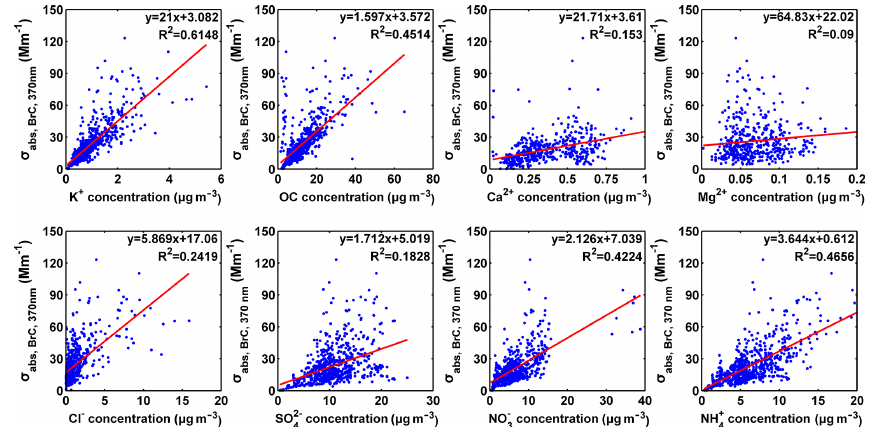
Figure 8. Correlations of the BrC absorption coefficient at 370nm with OC, water-soluble K + , Ca 2 + , Mg 2 + , Cl − , SO 2 − aerosol concentrations.